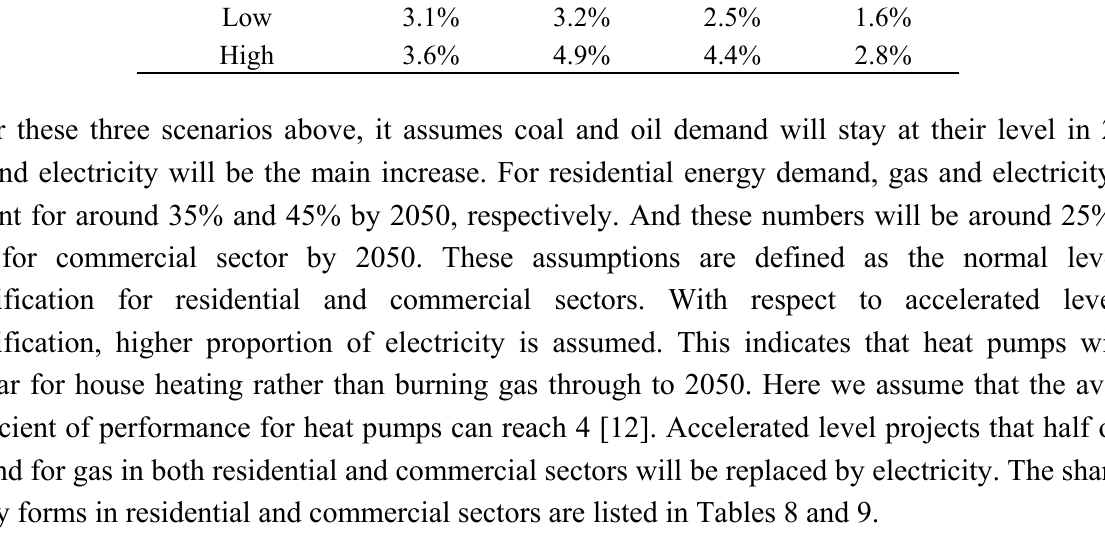
Table 8. Shares of different energy forms in residential demand by